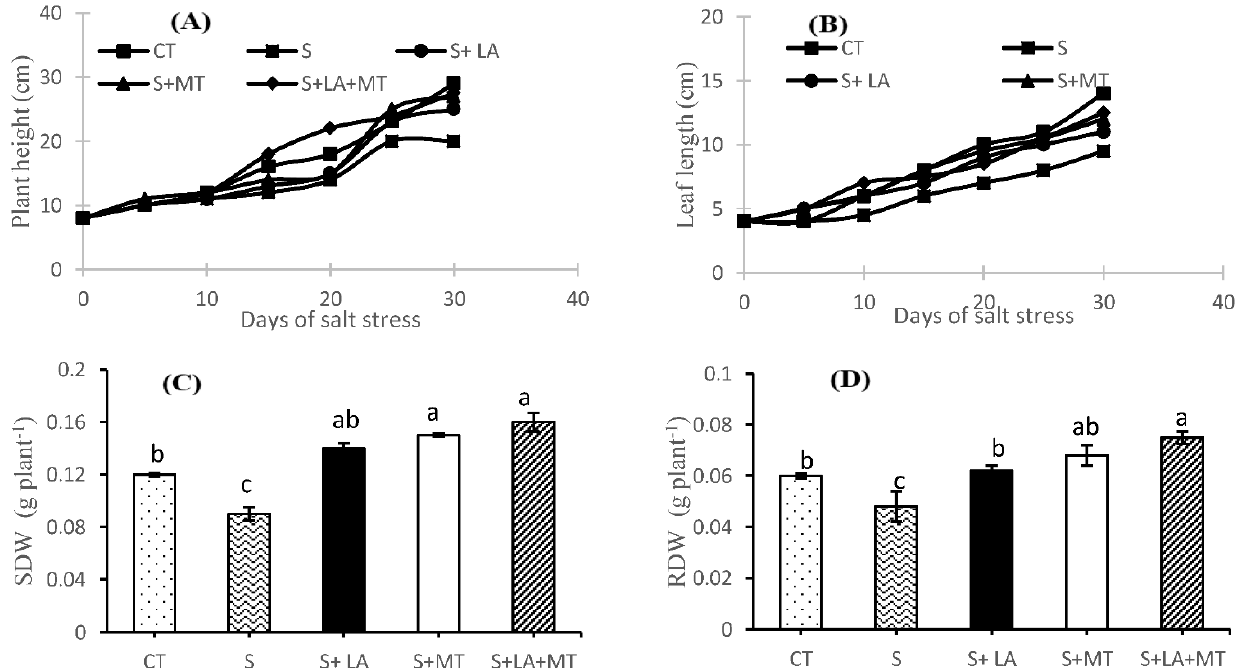
Figure 1. The effect of lipoic acid (LA), melatonin (MT), and their combination (LA + MT) under salt stress on plant height ( A ), leaf length ( B ), shoot dry weight (SDW) ( C ), root dry weight (RDW) ( D ) of Brassica napus L. seedlings exposed to salinity (100 mM NaCl) for 30 days. Abbreviation; CT, control; S, salinity; S + LA, salinity + lipoic acid; S + MT, salinity + melatonin; S + LA + MT, salinity + lipoic acid + melatonin. Error bars on each column show the ± SE of three replication samples. Different letters on each bar indicate a significant difference according to the LSD test ( p ≤